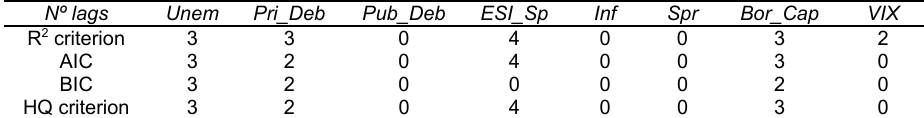
Table 5. Number of lags to be considered for each criterion and for each variable Nº lags